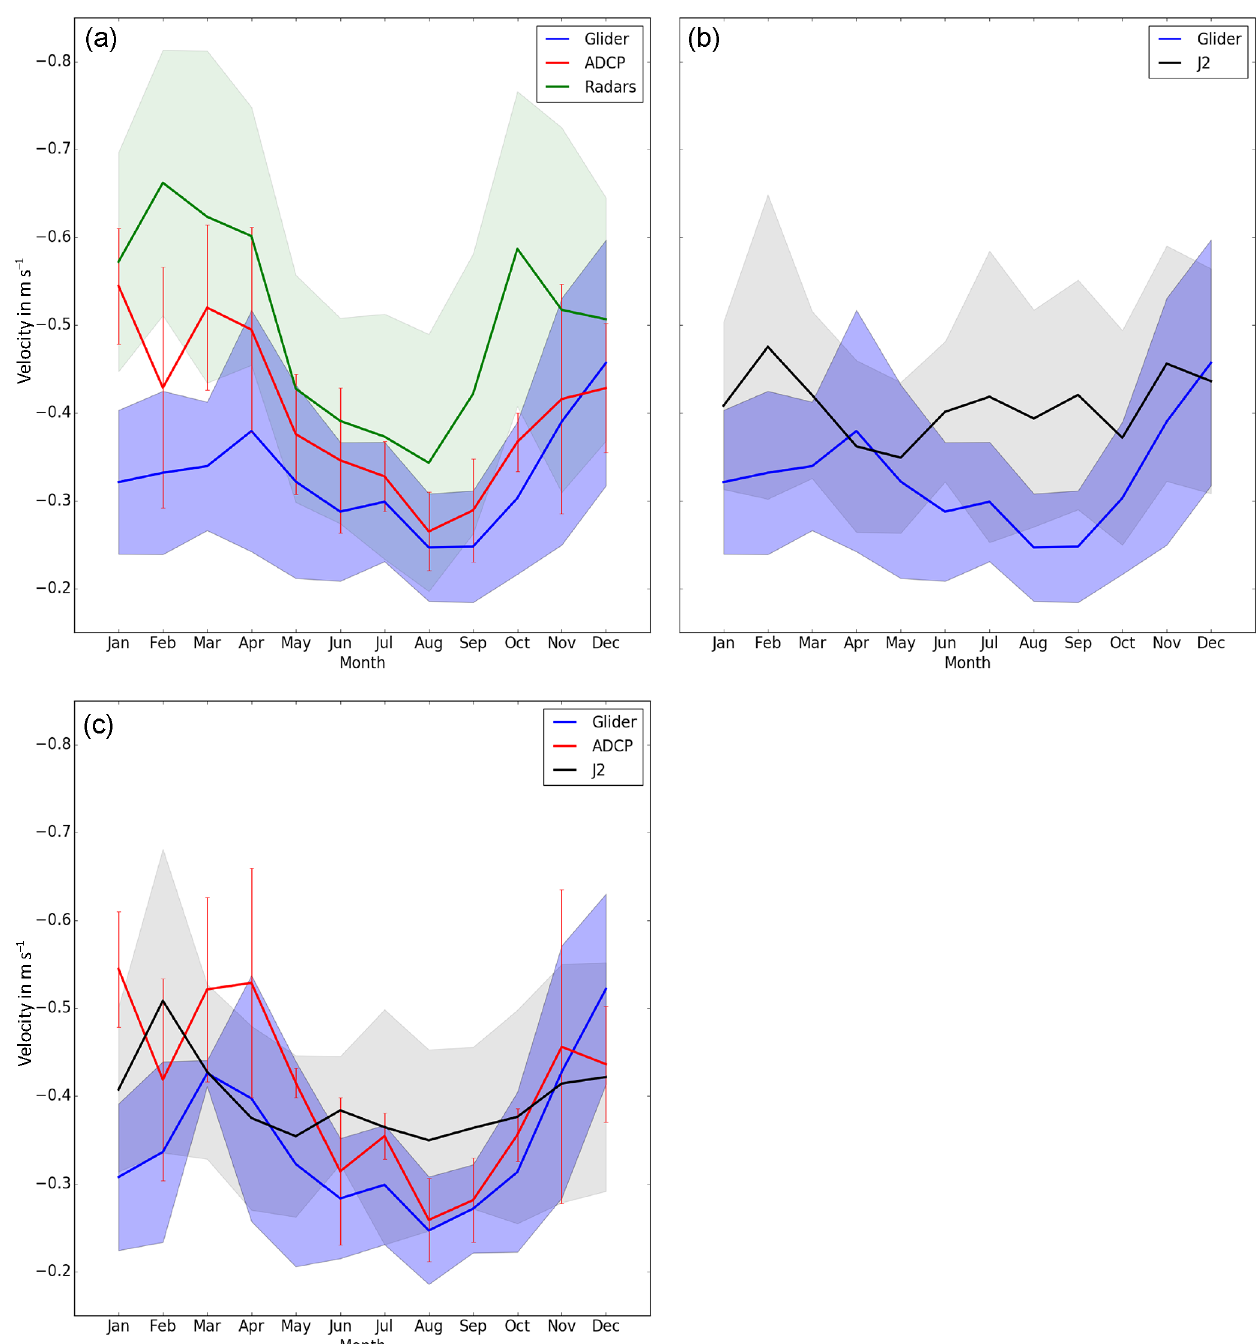
Figure 5. Seasonal variations of the maximum current amplitude derived from the (a) HF radars (green line), ADCP (red line), gliders (blue line), and (b) Jason-2 (black line) and glider (blue line) observations available over the period 1 January 2010–31 December 2016. (c) Same as (a) and (b) but computed over the period July 2008 to June 2014 and only for the gliders, ADCP and Jason-2. For all the curves the monthly standard deviation of the maximum current amplitude derived from the corresponding instrument is also indicated (curve envelopes and error